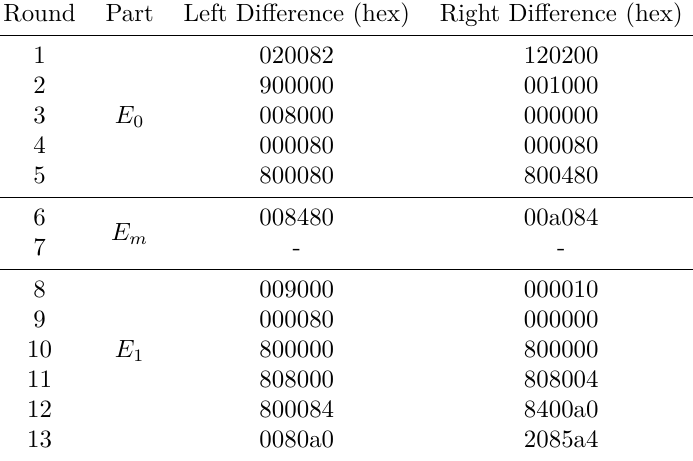
Table 7: A Boomerang Characteristic for